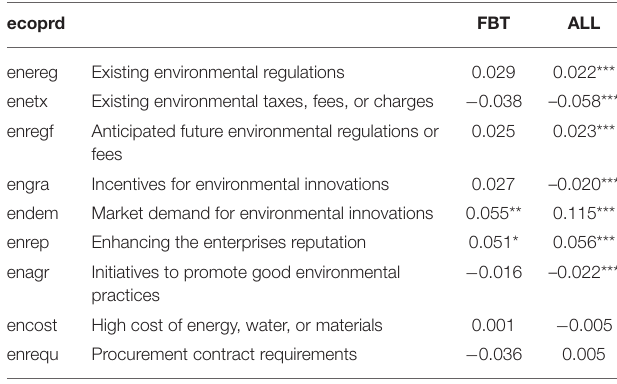
TABLE 4 | Multivariate regression parameters to determine the factors that contribute to the circular benefits of product innovations. ecoprd FBT ALL